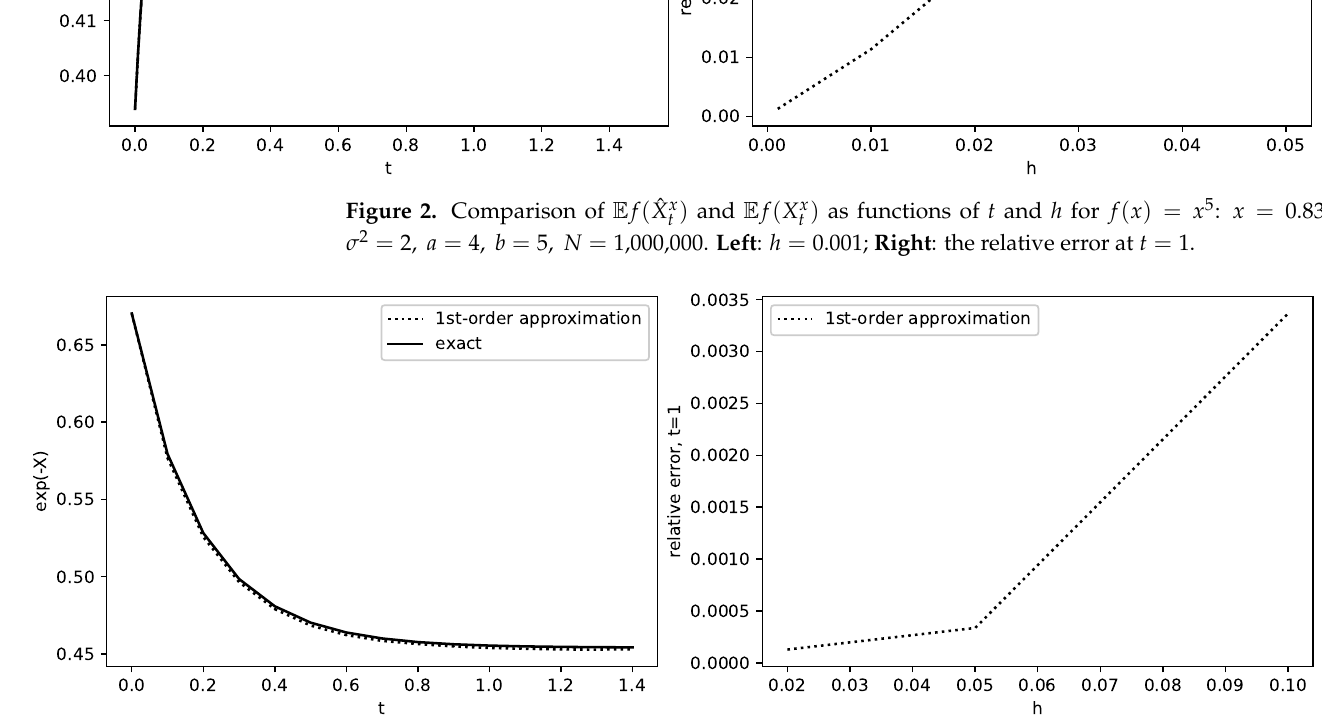
Figure 3. Comparison of E f ( ˆ X x σ 2 = 1.6, a = 4, b = 5, N = 100,000. Left : h = 0.1; Right : the relative error at t =